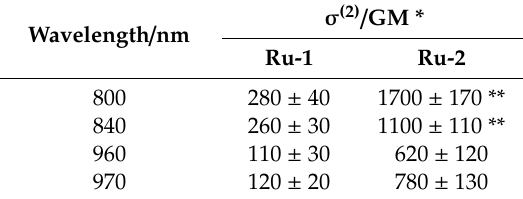
Figure 5. Comparison of the TPA spectra of ( a ) Ru-1 and ( b ) Ru-2 complexes with (circle) or without (triangle) stirring the solution. Table 2. TPA cross-section σ ( 2 ) values obtained with the power-scan